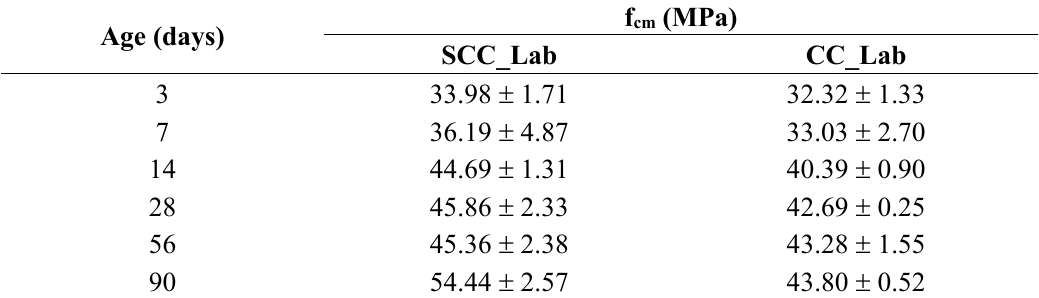
Table 4. Results of the compressive strength (f cm ) for the research laboratory